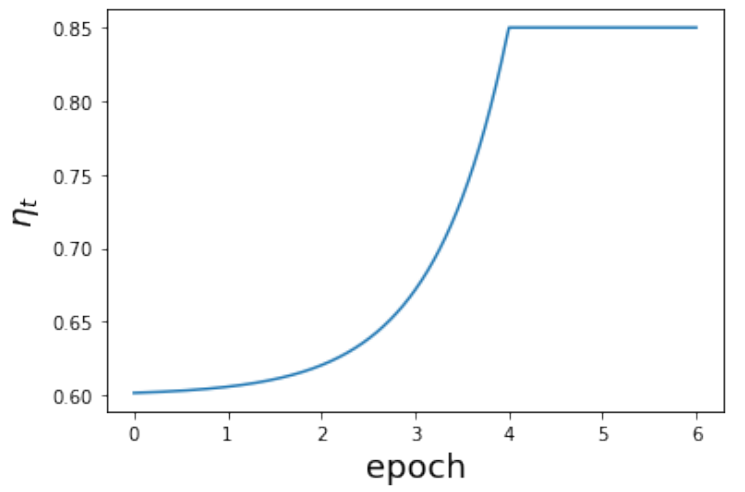
Figure A1. Exponential schedule. We introduce maximum η max and minimum η min threshold, run maximum 6 epochs and set the epoch E as 4 where schedule reach η max . Empirically, exponential schedule is suitable for the model, in particular, which is suffering from learning MCs pattern. We set × 5 )) × ( η max − η ) + η ) , where T is the product of the total steps η t = min (( 1 − exp ( − t min min , η max T per epoch and E